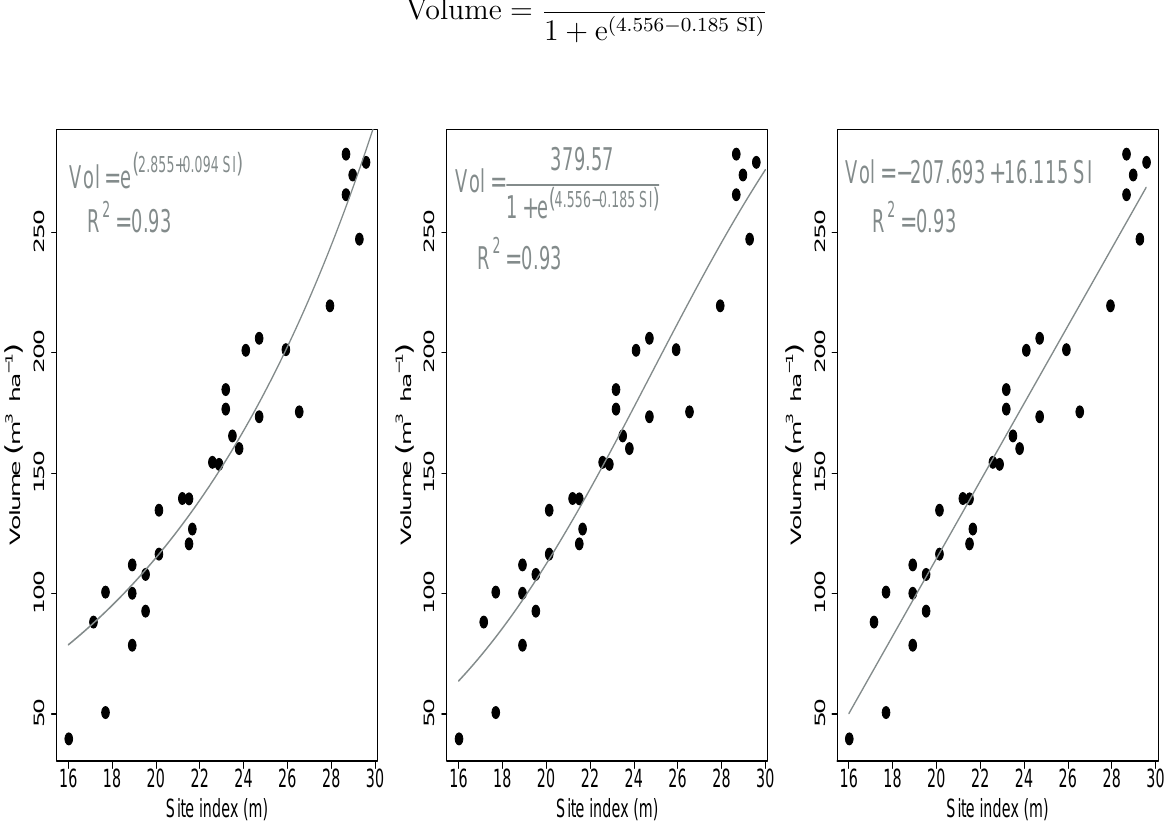
Figure 2. Scatter plots between stand volume (m 3 ha − 1 ) and site index (m). Left, middle, and right diagram show the exponential, sigmoidal, and linear relationships,